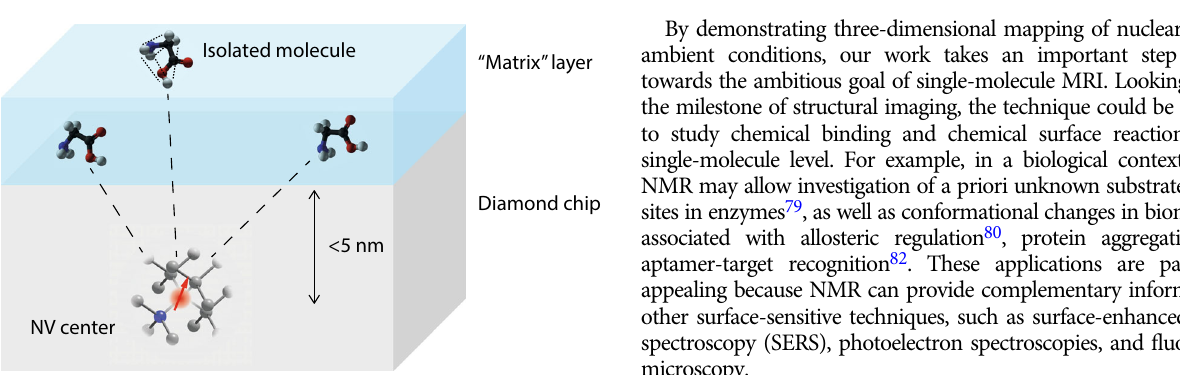
Fig. 6 Proposed strategy for single-molecule MRI. A few molecules of interest are immobilized on a diamond surface containing <5-nm-deep NV centers. Molecules are protected by a spin-free “ matrix ” layer (blue shading). The global position and conformation of molecules are imaged by our weak-measurement localization scheme (dashed lines), while precise local distances between nuclei are measured using two-dimensional NMR (dotted lines). Computational analysis is used to extract three-dimensional atomic